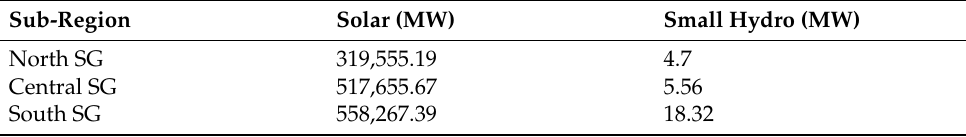
Figure 20. Final map showing South smart grid suitability area. Table 5. Potential power generation capacity of solar and hydro per areal smart grid